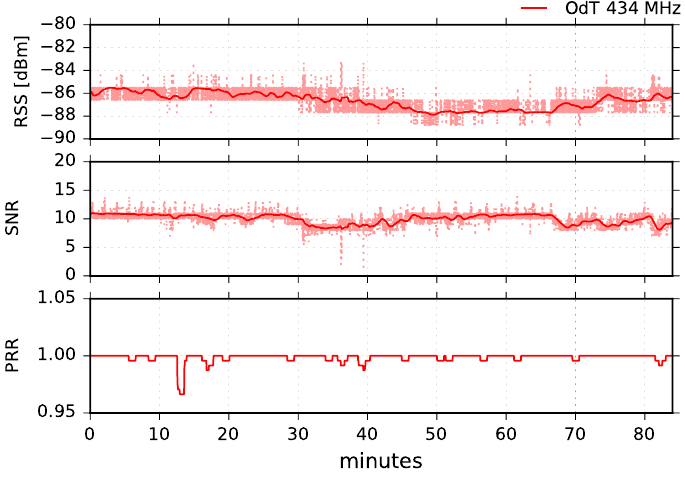
Figure 15. RSS, SNR, and PRR for ODT at 434MHz in LOS channel conditions for BW = 125kHz, SF = 7, and CR =